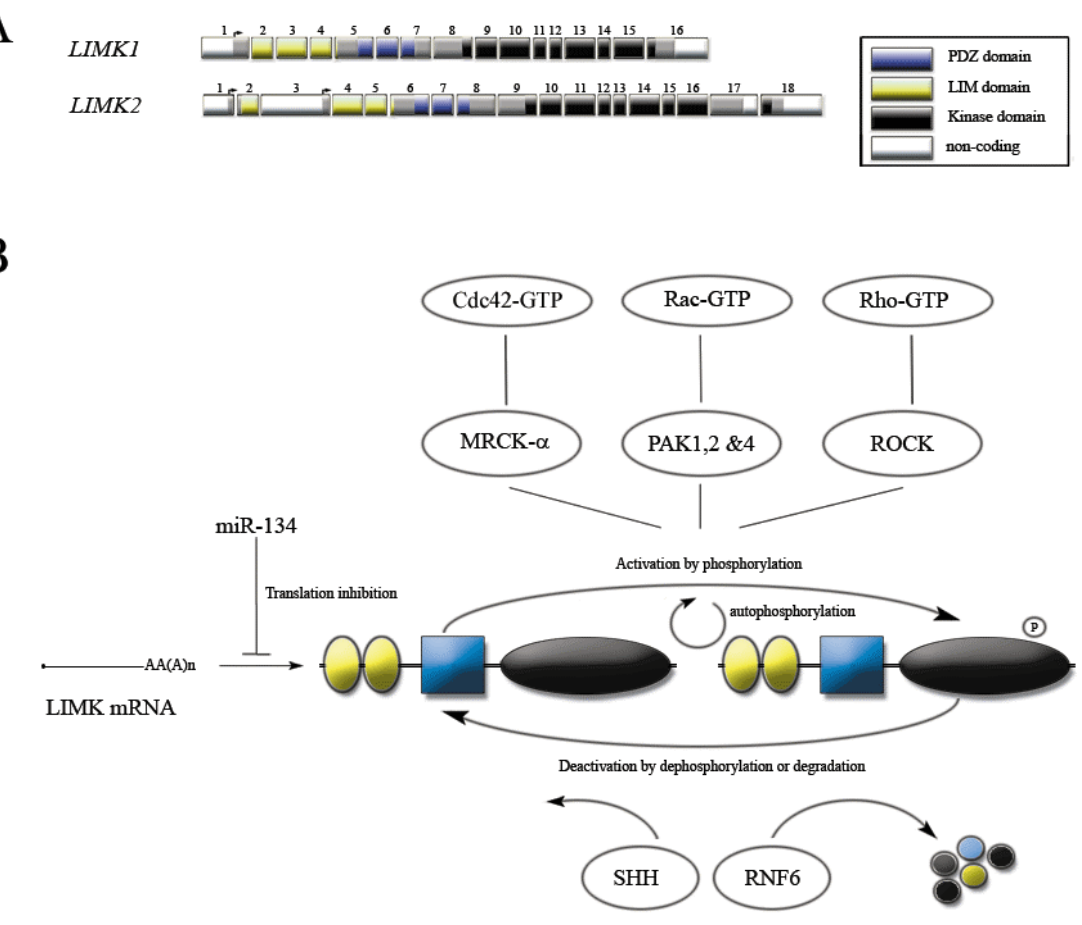
FIGURE 3. (A) The gene structures of the LIM domain kinases. Shown is an overview of the LIMK gene structures as harbored by the human genome. Structures are based on Ensembl references: LIMK1 (ENSG00000106683, OTTHUMG00000023448) and LIMK2 (ENSG00000182541). The PDZ and LIM domains are colored blue and yellow, respectively. The functionally important kinase domain is encoded by nine exons. An alternative transcription initiation site is also indicated for the LIMK2 presenting structure. (B) Regulation of LIMK activity. LIMK activity and expression are highly regulated processes. First, translation of the LIMK-encoding mRNA may be reduced through microRNA miR-134. Phosphorylation and activation of LIMK can be mediated via three different pathways, all including members of the Rho GTPase family. Phosphorylation may also be a result of a transinteraction of two LIM kinases in vitro . Finally, inactivation of LIMK may result from dephosphorylation by Slingshot (SHH) or degradation induced by